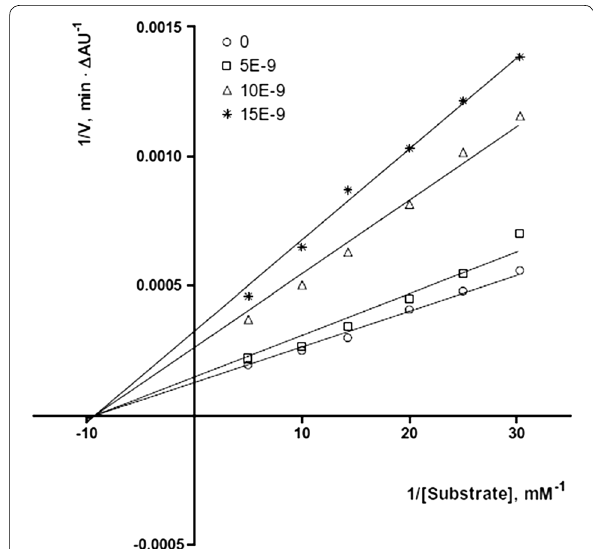
Fig. 40 Lineweaver–Burk plot of inhibition kinetics of C41m (entry 13): reciprocals of enzyme activity (bovine AChE) vs reciprocals of substrate ( S -acetylthiocholine) concentration in the presence of different concentrations (0–15 nM) of inhibitor C41m (entry 13) [51]